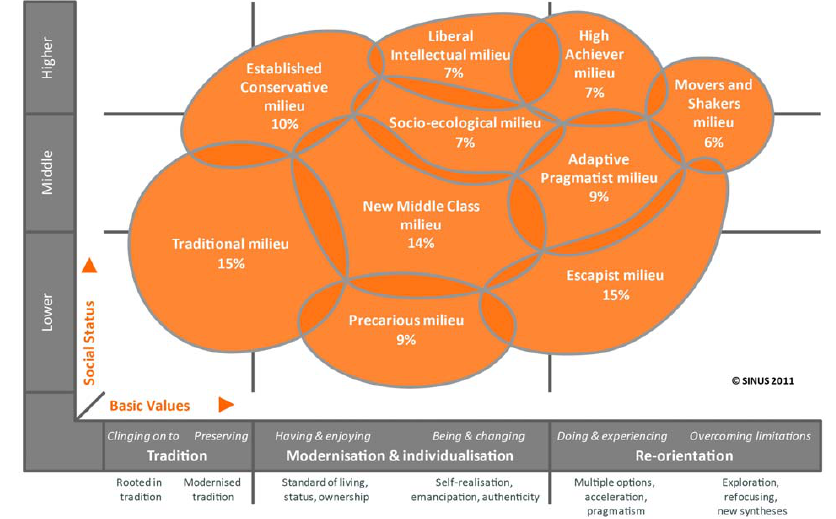
Fig. 3. Sinus Milieus® in Germany 2011 (source: SINUS-Institut, Figure 3. Sinus Milieus ® in Germany 2011. (Source: SINUS-Institut, Heidelberg) 4